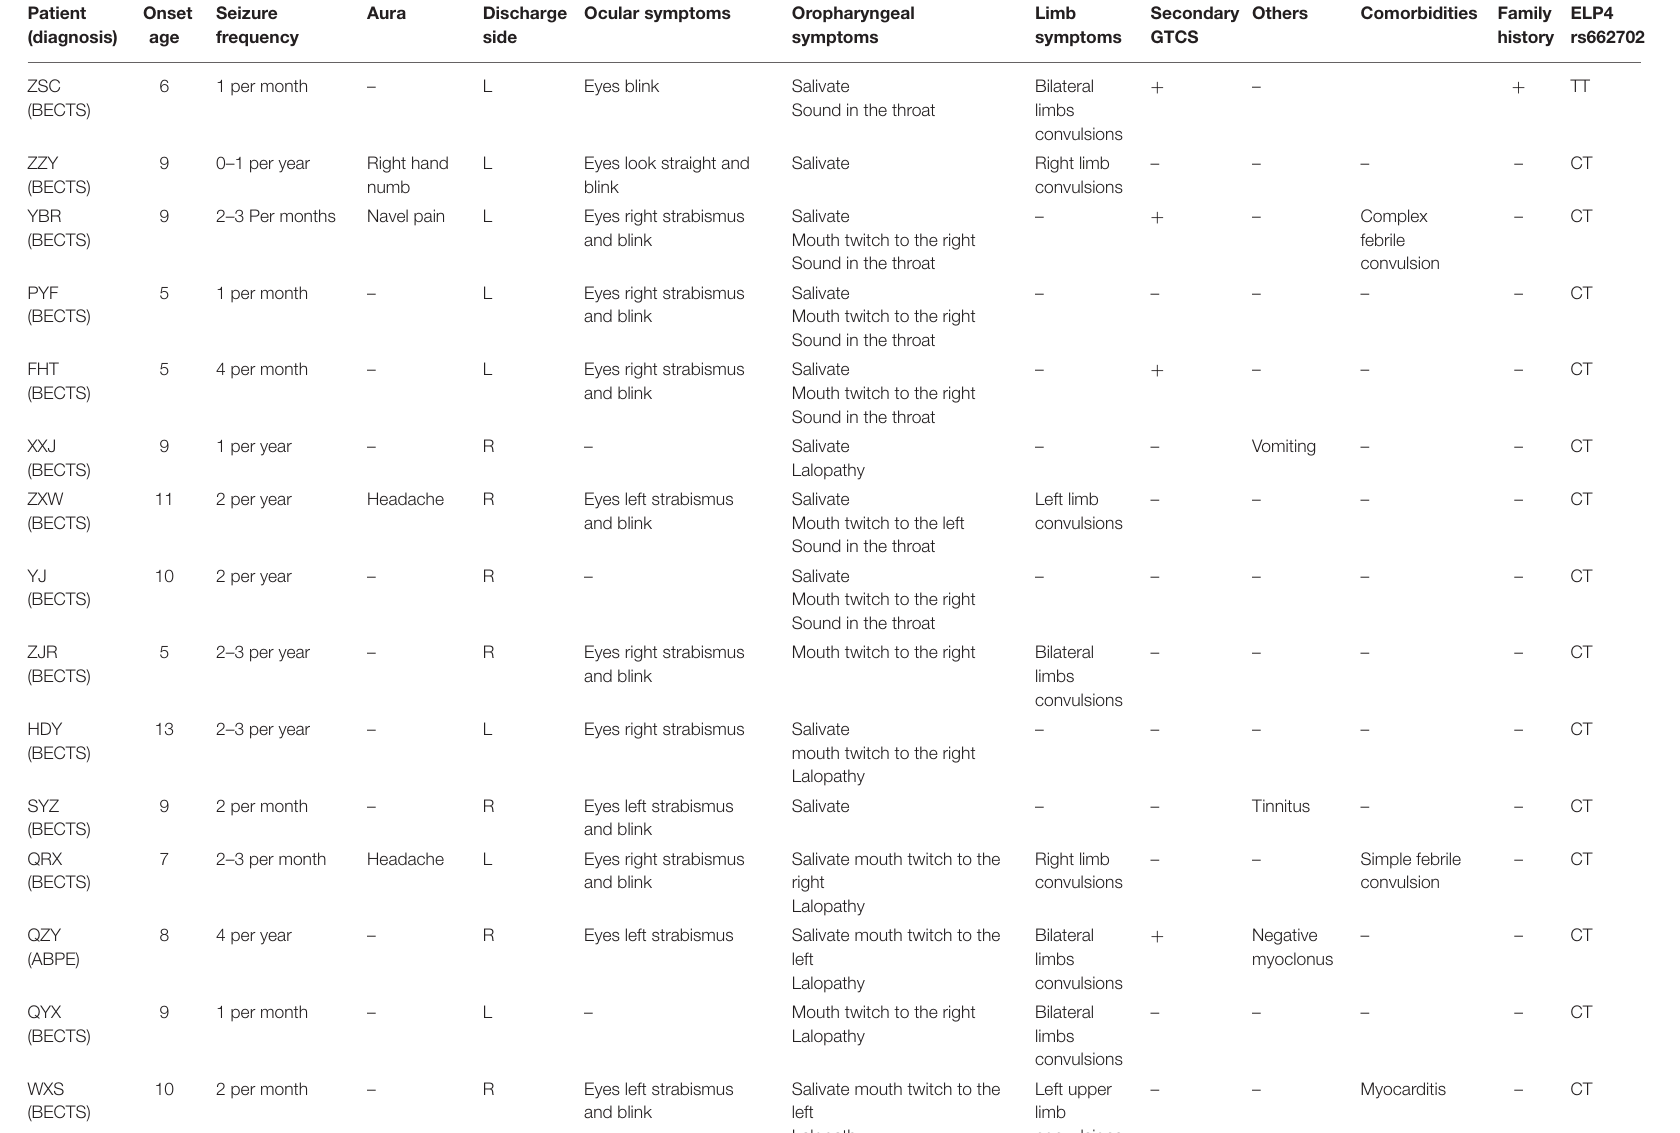
TABLE 2 | Abnormal genotypes and clinical phenotypes of ELP4